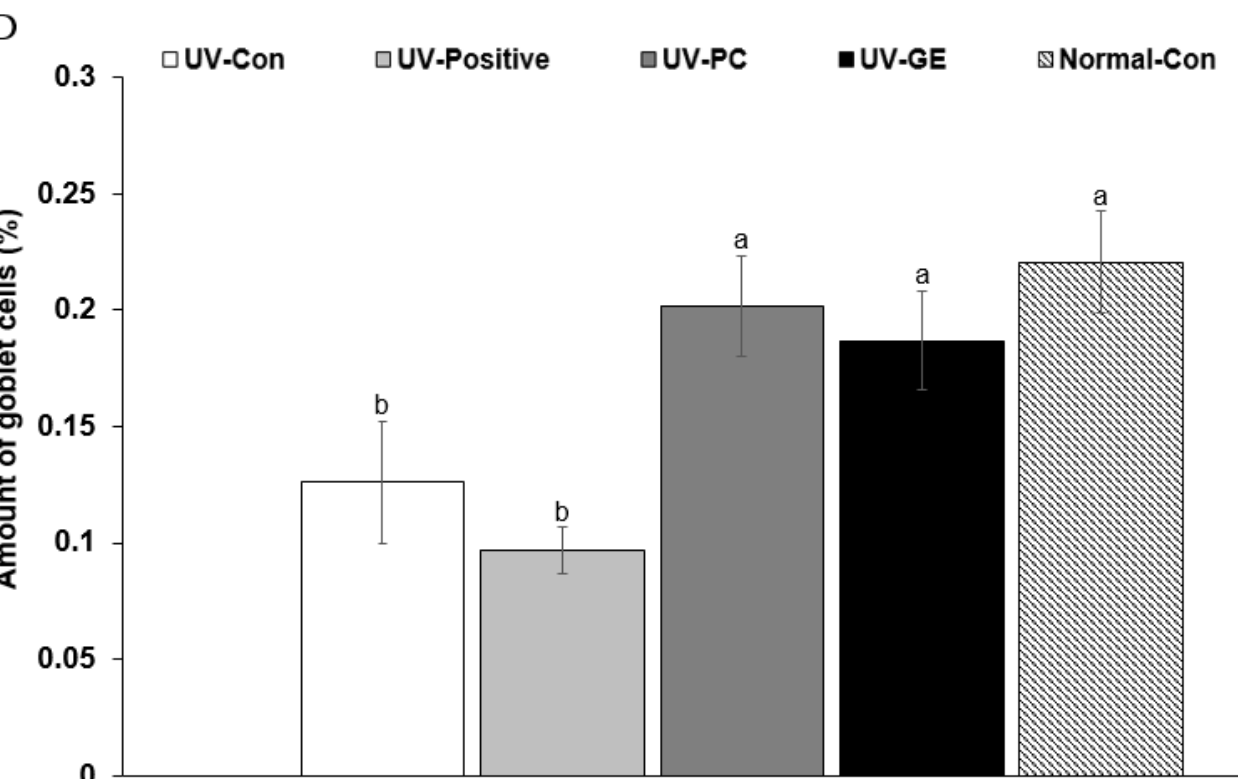
Figure 3. Histological differences and the amounts of mucin in the intestinal tissues among different groups. The intestinal tissues were fixed with 10% formaldehyde, embedded in paraffin, and sections were prepared. The large intestine sections were stained with hematoxylin-eosin and toluidine blue. The magnification of the image was 100×–200×. ( A ) Histology of the intestinal tissues by hematoxylin and eosin staining. Redline: Large intestine villi width, Blackline: Length of the large intestine villi, Blueline: Intestinal crypt. ( B ) Scores of the villi length, intestinal crypt, and large intestine villi width(mm). The higher scores (%), the healthier the colon. ( C ) Percentage of mucin in the large intestinal tissue Goblet cells producing mucin were marked with red circles in the large intestinal tissues. ( D ) Intestinal goblet cell score (%). a,b,c Means with different superscripts were significantly different among the groups in each parameter by the Tukey test at p < 0.05.